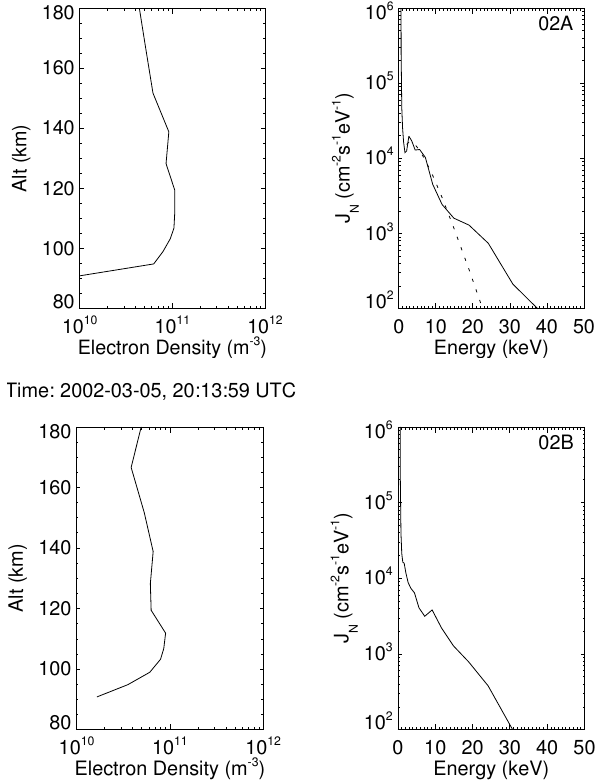
Fig. 7. Electron density profiles and differential number flux (cal- culated through inversion of the density profile) for events 02A and 02B. When applicable, a Maxwellian function (dotted line) has been fitted to the secondary peak in the spectra. This gives approxima- tions to the characteristic energy ( E 0 ) and temperature ( kT ) of the precipitating electron